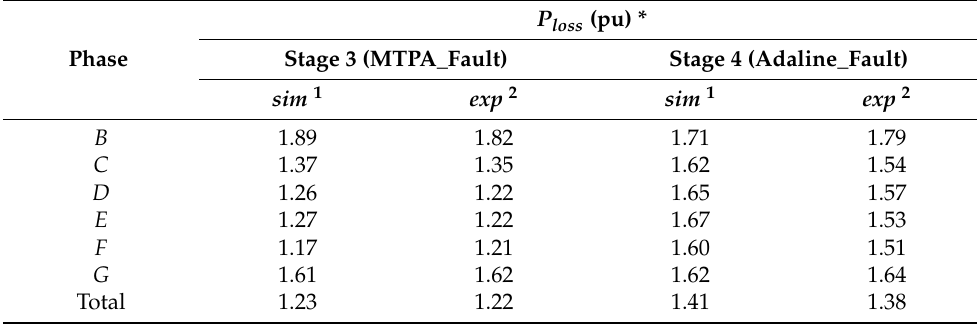
Table 5. Comparisons between stage 3 (MTPA_Fault) and stage 4 (Adaline_Fault) at 300 rpm in terms of copper losses when phase A is opened.